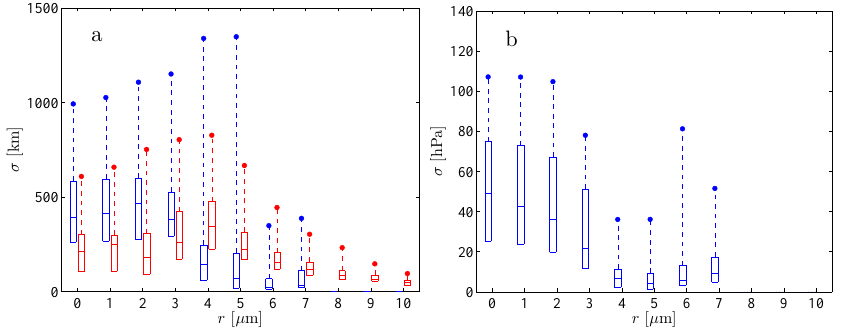
Fig. 9. The statistics of the standard deviation around the center of mass over the 50 ensemble members in horizontal (a) and in vertical (b) after 2.5 days averaged over the particles that remain in the atmosphere (blue) or deposit (red). Lower and upper quartiles (the bottom and the top of the boxes), and medians (horizontal lines in the boxes) are plotted. Filled circles denote the standard deviation over the whole ensemble forecast for particles that remain in the atmosphere or deposit.